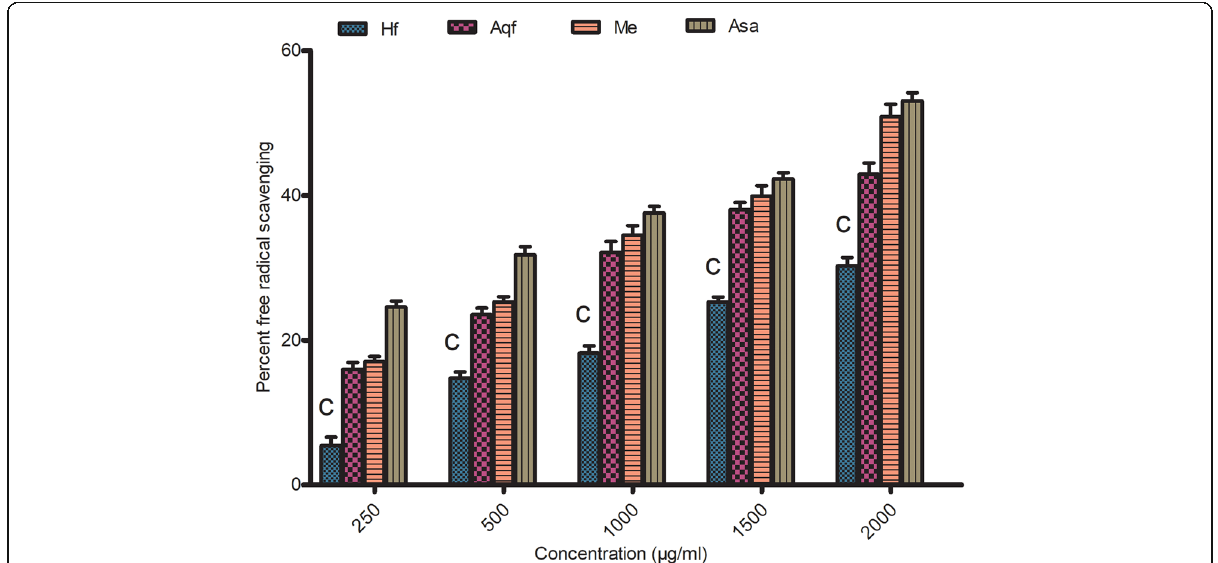
Fig. 3 H 2 O 2 free radical scavenging capability of the rhizome of Sorghum halepense (L.) Pers methanolic extract and its fractions. Aqf: aqueous fraction, Cf: chloroform fraction, Hf: n -hexane fraction and Me: methanolic extract Asa: ascorbic acid. The scavenging effect of extract and ascorbic acid were compared. c indicates significance at p < 0.05 (Dunnett ’ s-test). Performed the experiments in triplicate ( n =